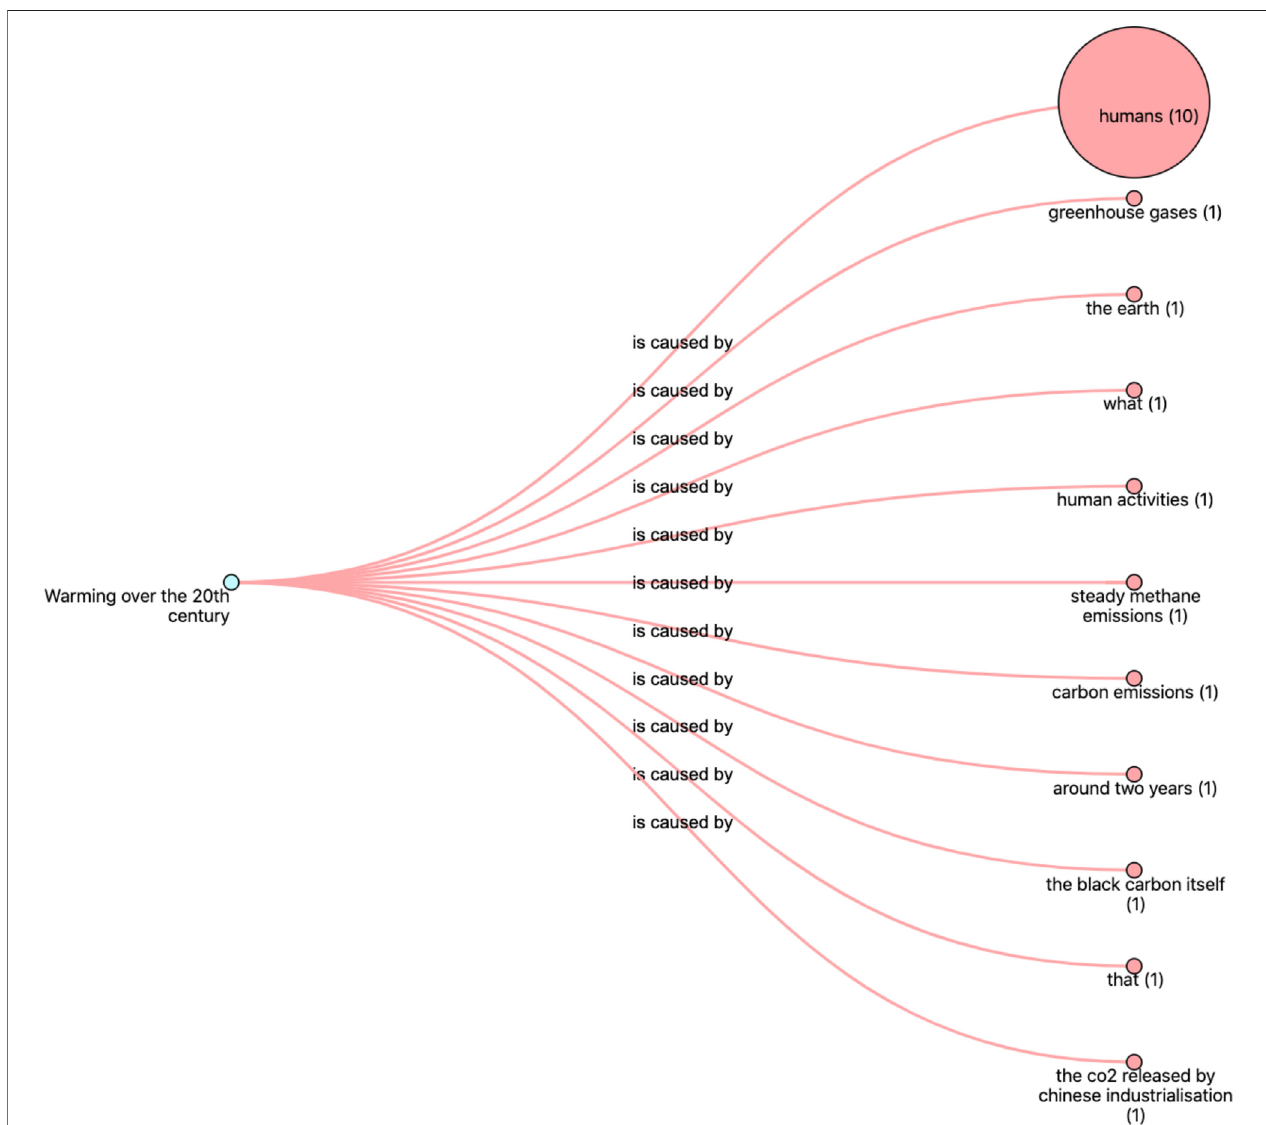
FIGURE 6 | Detail of the Penelope opinion facilitator ’ s graph overview of retrieved frames. The node on the left represents the selected effect “ Warming over the 20th century, ” the nodes on the right represent the associated “ cause ” frame elements retrieved from the articles (for 20 articles). The node sizes are proportional to the frequency of the retrieved frame elements. From this representation, it is clear that “ humans ” are most frequently mentioned as the cause of “ warming over the 20th century. ”